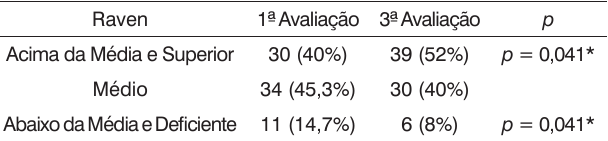
Tabela 3. Comparação do Desempenho do Nível Intelectual do Teste das Matrizes Progressivas Coloridas de Raven - Escala Especial da 1ª avaliação para 3ª